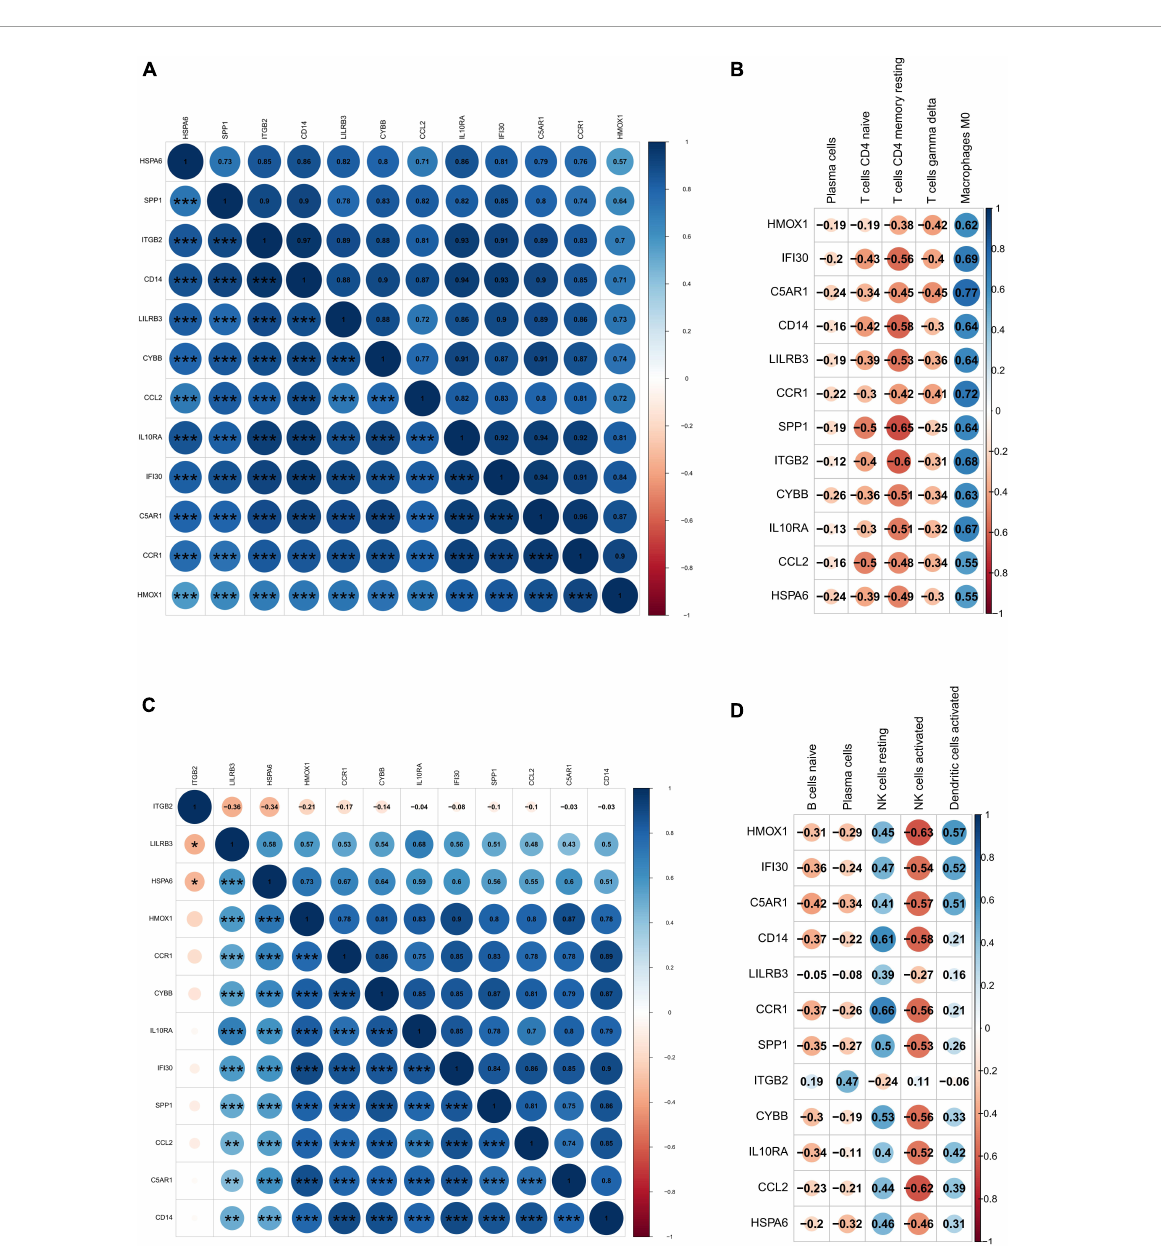
FIGURE7 Correlation analysis of differentially expressed immune-related genes and immune cells. (A) Heat map of the correlation between differentially expressed immune-related genes in carotid artery plaque samples. (B) Heat map of the correlation between differentially expressed immune-related genes in vascular dementia samples. (C) Heat map of the correlation between differentially expressed immune-related genes and differentially expressed immune cells in carotid artery plaque samples. (D) Heat map of the correlation between differentially expressed immune-related genes and immune cells in vascular dementia samples. Significance level was denoted by * p -value < 0.05, ** p -value < 0.01, *** p -value <